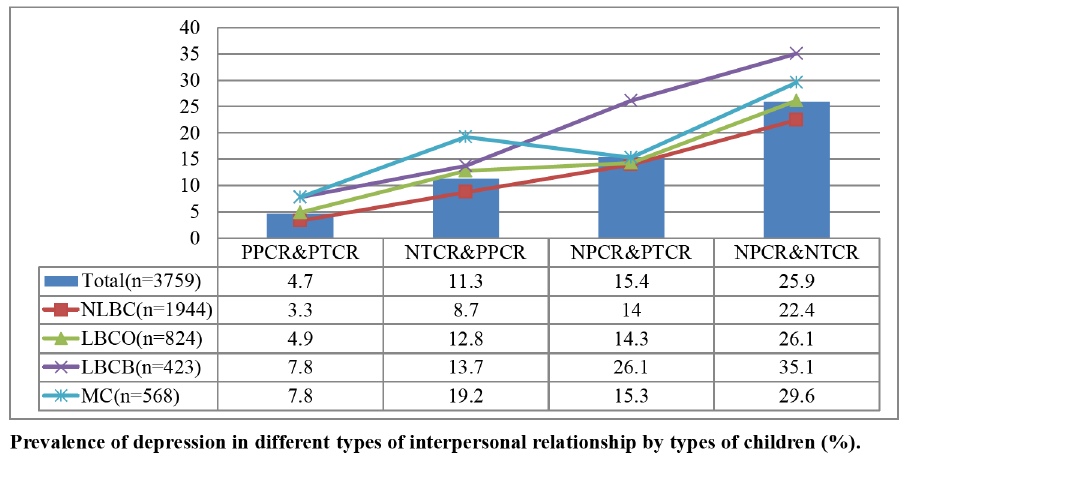
Fig 1. Prevalence of depression in different types of interpersonal relationship by types of children (%). There are highest prevalence of depression in NPCR&NTCR for all types of children. For NTCR&PPCR, MC have the highest prevalence of depression. For NPCR&PTCR, LBCB have the highest prevalence of